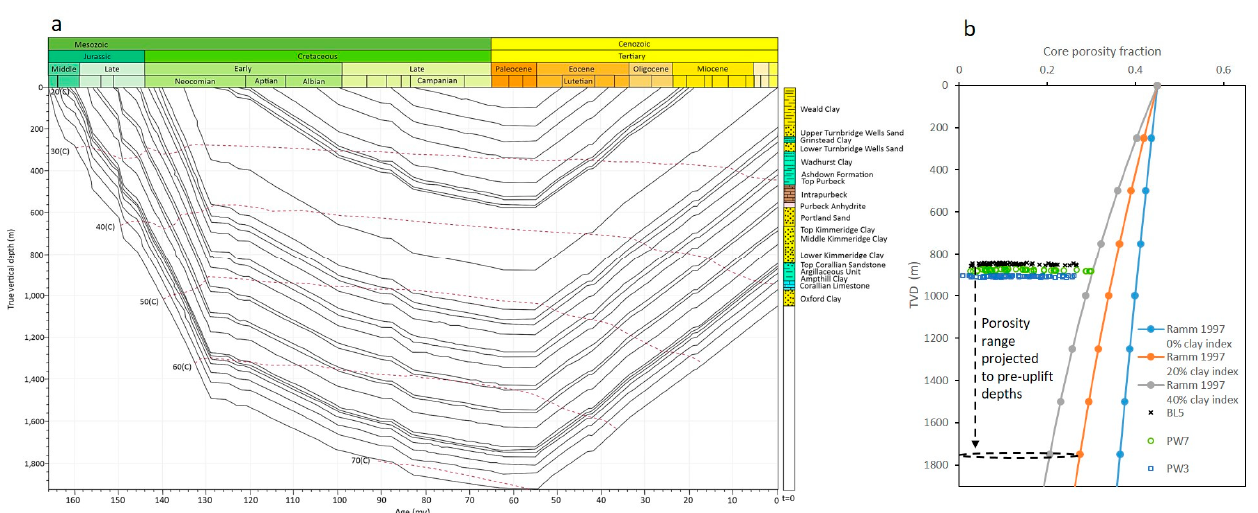
Figure 15. ( a ) Burial curve for the Weald area around Bletchingley-5 showing burial to the base of well BL5 in the Oxford Clay up to ~1920 m. The curve also shows uplift from 55 Ma to current depths. ( b ) Shows modelled compactional po-rosity-loss curves at different clay content after Ramm [38] and core porosity fractions from BL5, PW7 and PW3. Porosity loss in the Corallian sandstones did not follow the expected trend for mechanical compaction.